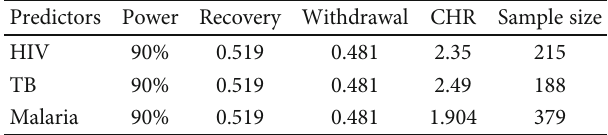
Predictors Power Recovery Withdrawal CHR Sample